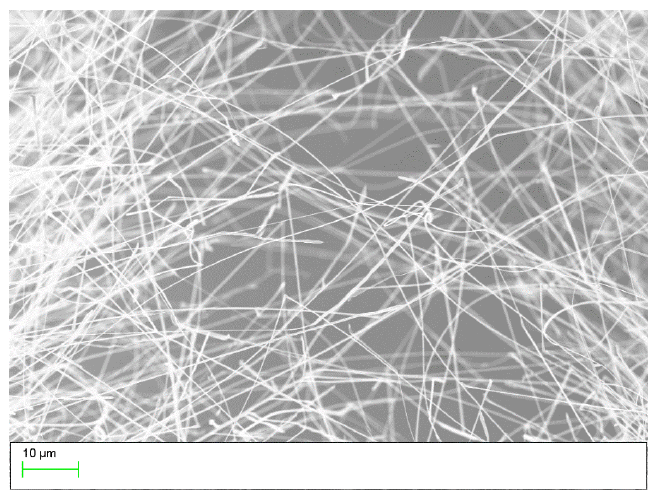
Figure 1. A SEM picture of SnO 2 NWs grown on Si substrate.